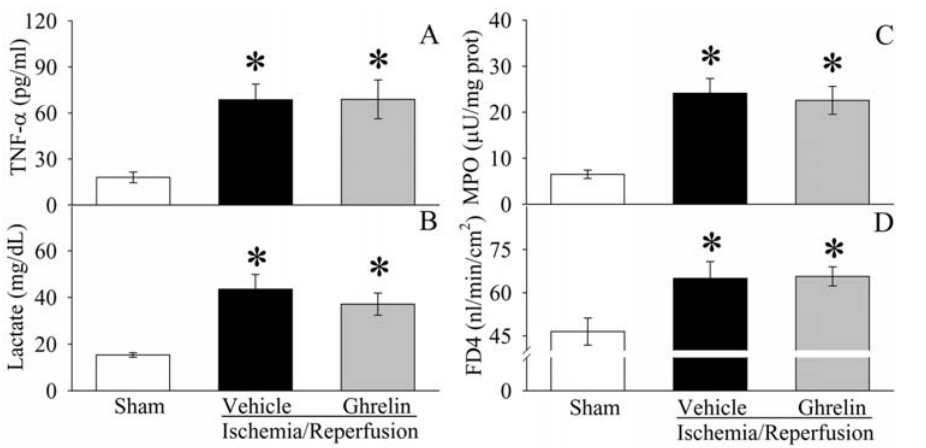
Figure 9. Effects of vagotyomy on serum levels of TNF- a (A) and lactate (B), intestinal MPO activities (C), and intestinal mucosal permeability (D) to fluorescein isothiocyanate dextran with a molecular weight of 4000 Da (FD4) in sham-operated animals (Sham) and ischemia/reperfusion animals treated with normal saline (Vehicle) or ghrelin (Ghrelin) at 1.5 h after the completion of treatment (i.e., 2 h after reperfusion). Data are expressed as means 6 SE (n=6–7/group) and compared by one-way analysis of variance (ANOVA) and Student-Newman-Keuls test: * P , 0.05 versus sham-operated animals.